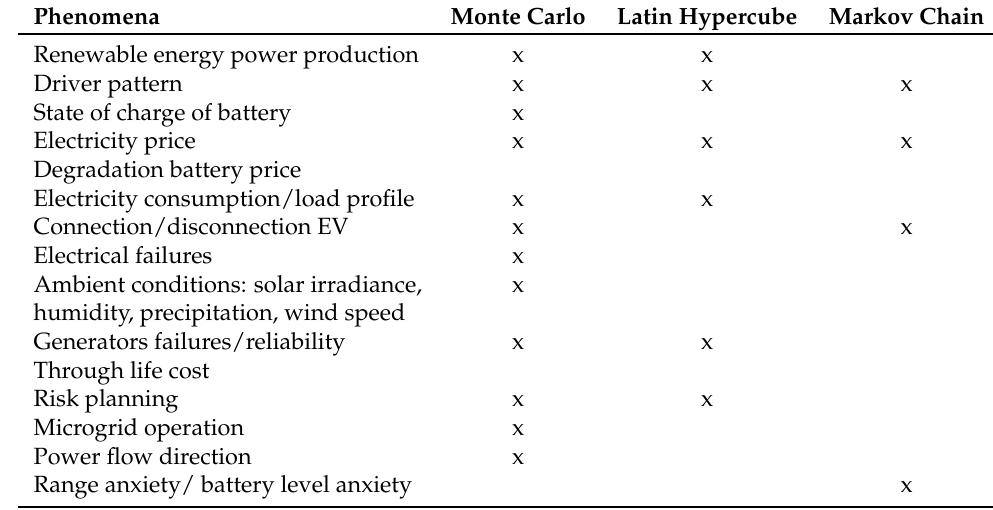
Table 8. Uncertainties considered with sample techniques.